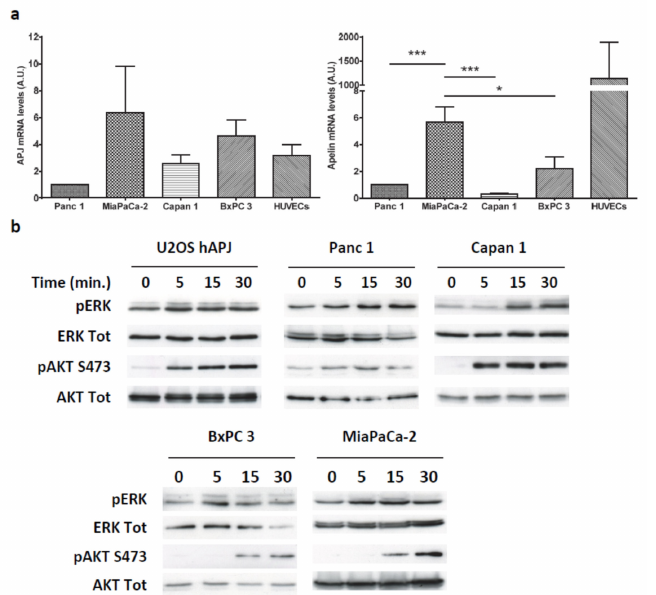
Figure A5. Human pancreatic tumor cell lines endogenously express apelin receptors and respond to apelin. ( a ) Quantitative real-time polymerase chain reaction (qRT-PCR) analysis of APJ and apelin genes with quantification relative to Panc-1 cells (set at 1). n = 10. Human umbilical vein endothelial cells (HUVEC, at passage 3), which endogenously express apelin, and its receptor were used as positive control. Statistical significance between groups was assessed by using one-way ANOVA (*) p ≤ 0.05, (***) p ≤ 0.001. ( b ) Human pancreatic tumor cell lines respond to exogenous apelin. U2OS stably expressing APJ, Panc 1, Capan-1, BxPC3 and MiaPaCa-2 cell lines were serum-starved for 20 h and then stimulated with apelin (500 nM) for indicated time and ERK and Akt phosphorylation were analyzed by Western blot (n =